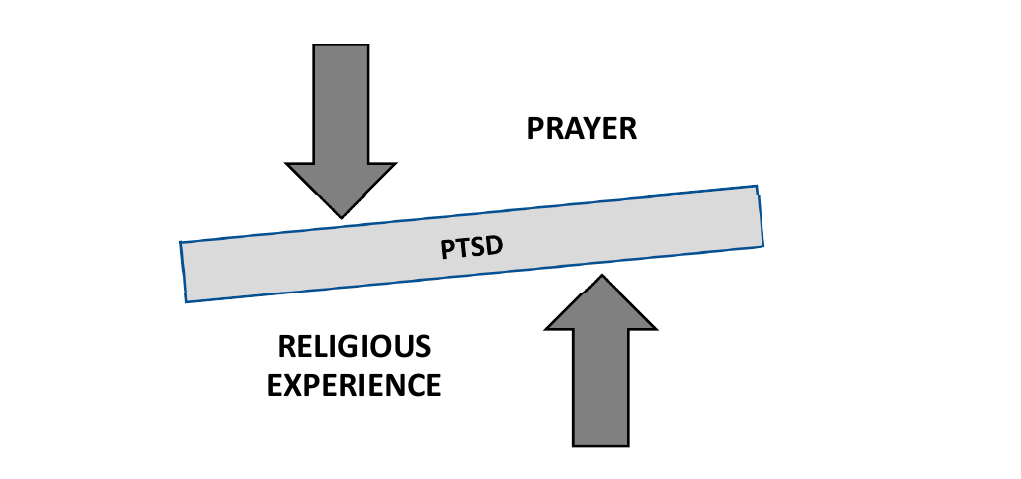
Figure 2. The influence of religious experience and prayer on the severity of PTSD symptoms in the study group—“balm and risk”.